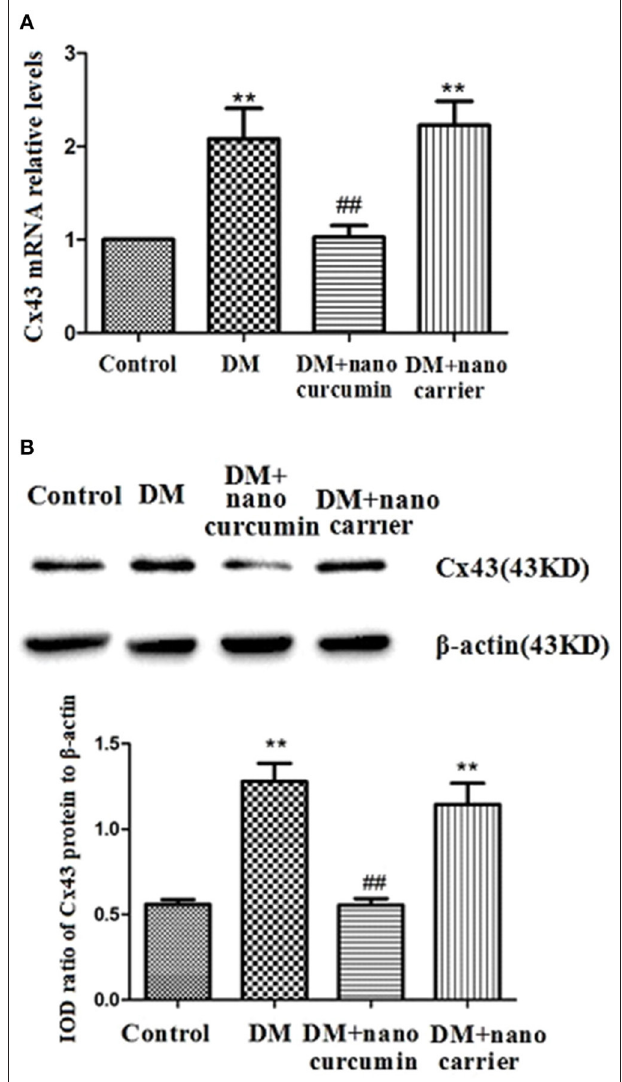
FIGURE 5 | Effects of nanoparticle-encapsulated curcumin on the expression of the interleukin-1 β (IL-1 β ) mRNA and protein in the DRG of the DM rats. (A) The expression of the IL- β mRNA in the DRG was measured by RT-qPCR. Expression levels of the IL- β mRNA were higher in the DM group than those in the control group ( p < 0.01). In DM rats treated with nanoparticle-encapsulated curcumin, the levels of IL-1 β mRNA expression were significantly decreased compared with those in the untreated DM rats ( p < 0.01). The experiment was performed three times ( n = 7 per group). Data are presented as means ± SEMs. ** p < 0.01 compared to the control group; ## p < 0.01 compared to the DM group. (B) The expression of the IL- β protein in the DRG was measured by Western blotting. Levels of the IL-1 β protein were higher in the DM group than those in the control group ( p < 0.01). In DM rats treated with nanoparticle-encapsulated curcumin, levels of the IL-1 β protein were lower than those in the untreated DM group ( p < 0.01). No difference was observed between the DM + nanoparticle-encapsulated carrier group and the DM group ( p > 0.05). Bar graphs show the ratio of the IL-1 β protein to the β -actin protein in each group. Data are displayed as means ± SEMs ( n = 7 per group). ** p < 0.01 compared to the control group; ## p < 0.01 compared to the DM group.